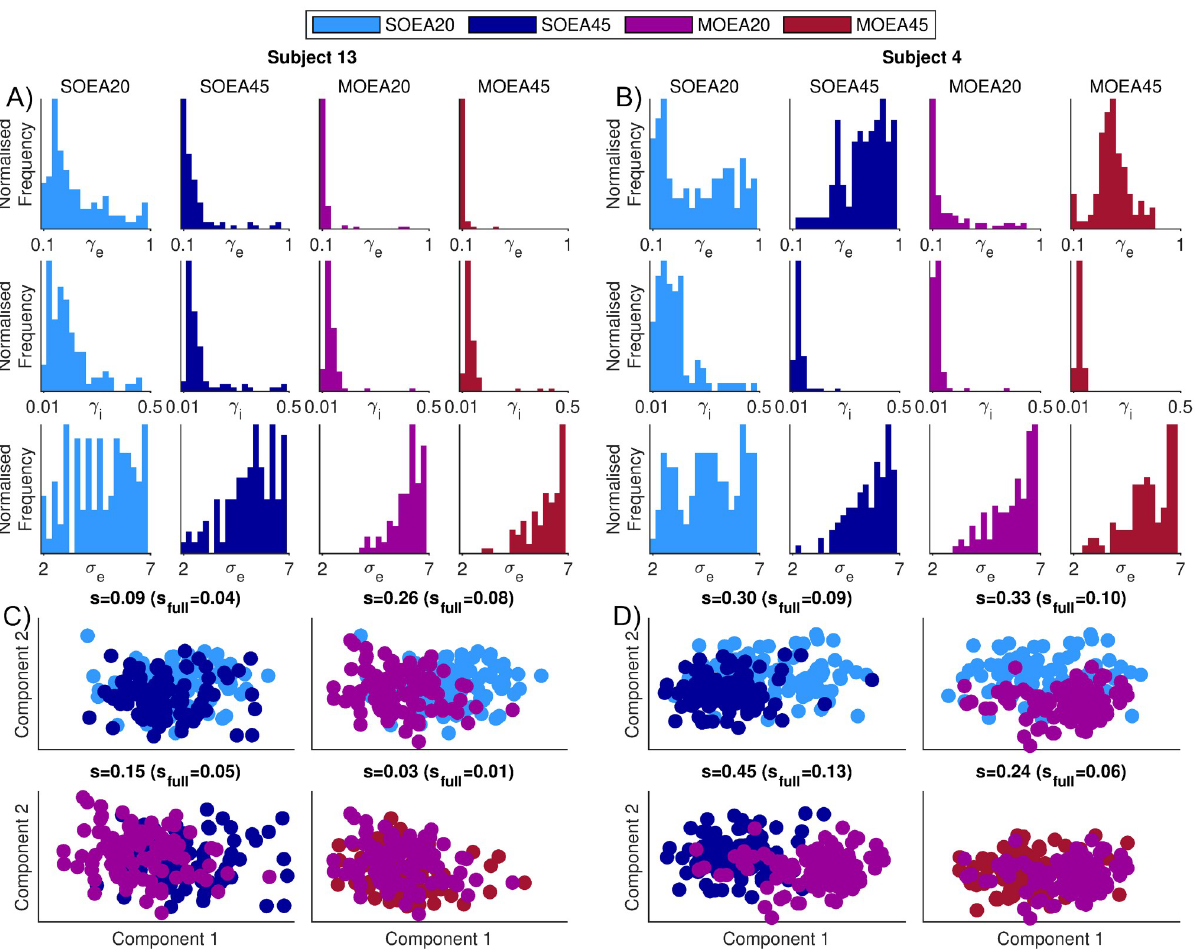
Fig 5. Example distributions of parameter values recovered from two subjects, using each algorithm. A) and B) show the distribution of 3 parameters ( γ e , γ i and σ e ) that were recovered from subjects 13 and 4, respectively. These were the same two subjects analysed in Fig 2. The parameter bounds are set to those used in the optimisation (see Table 1). For these subjects, C) and D) show the projection of each parameter set into the 2-d space found by applying a multi-dimensional scaling to the full parameter space. Each scatter point represents the optimal position in parameter space found by a single run of the optimisation algorithm. Optimal refers to the smallest Euclidean distance from the origin in objective space. The separation of these points in 2-d space is quantified by the silhouette score, with the silhouette score in the full space given in brackets.